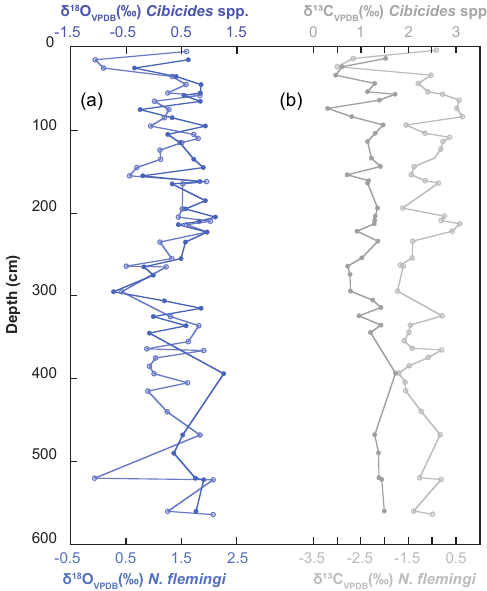
Figure 8. Downcore variations in δ 18 O foram for oxygen (left) and carbon (right) isotopes, 36P4, Hanfield Inlet. Solid circles represent Cibicides spp., and open circles represent N. flemingi. Both species show similar trends and similar magnitude of δ 18 O foram variation in downcore, although N. flemingi exhibits more positive values relative to Cibicides spp. (due to species-specific vital offsets; see Fig. 5). Both the trends and absolute magnitude of isotopic shifts for δ 13 C foram differ between the two species. N. flemingi exhibits more negative δ 13 C foram with a higher range of values, whereas Cibicides spp. exhibits more positive δ 13 C foram with a lower range. Note: we focus our palaeoclimate interpretations on the stratigraphic interval above